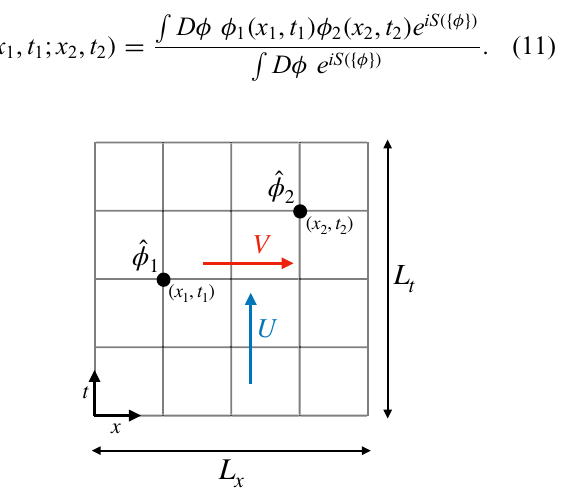
FIG. 6. Geometry for the correlation function C ( x 1 , t 1 ; x 2 , t 2 ) defined in the main text [Eq. (11)]. It can be interpreted in two different ways: either as a correlation function for a sys- tem evolving unitarily with circuit U , or as a correlation function for a system evolving with the rotated nonunitary circuit V ; see Eq.